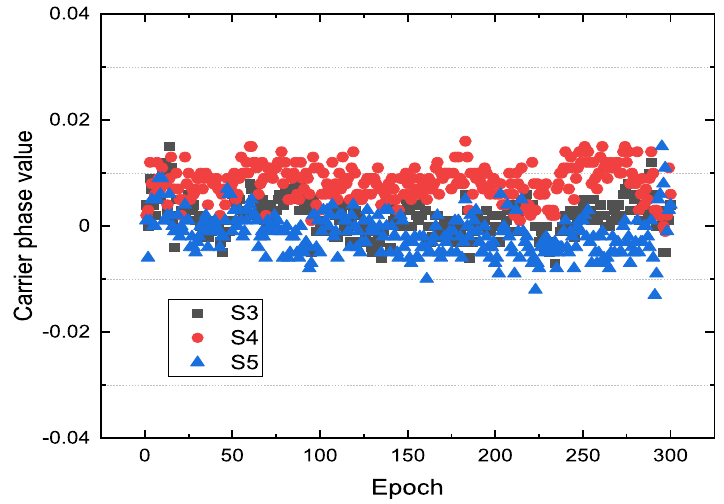
Figure 16. Base station carrier phase noise condition.